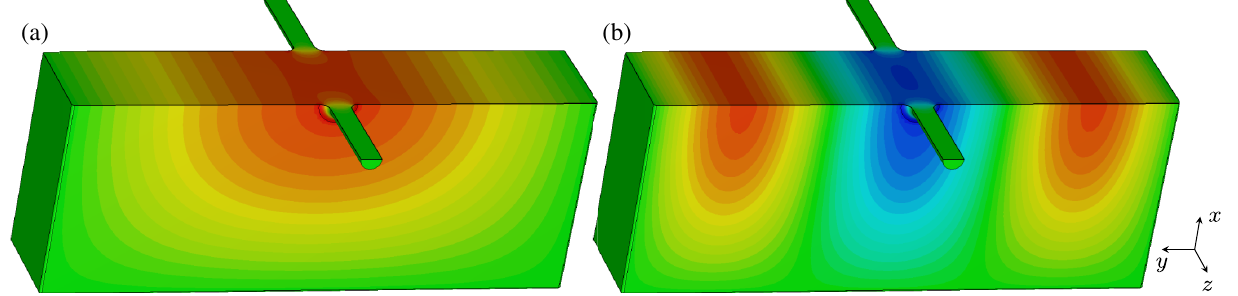
FIG. 12. Cross section of the (a) fundamental and (b) higher harmonic compression mode cavity. Colors represent the relative field strength of the electric field in the z -direction with red positive and blue negative, normalized to the maximum field strength. Cavity dimensions in mm are 189 . 6 × 244 . 78 × 47 . 3